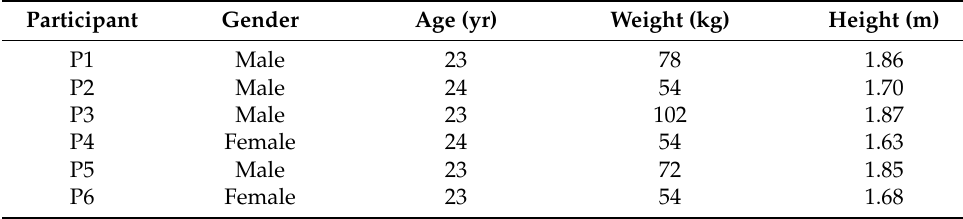
Figure 3. Dataset generation scenarios. Table 1. Brief physical description of the